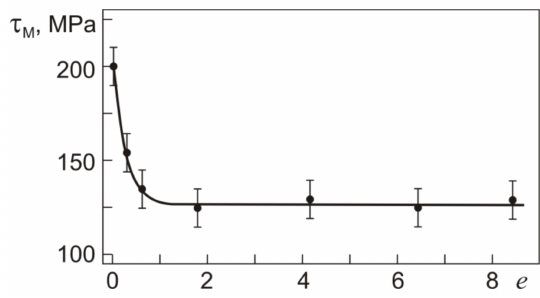
Figure 4. Martensite shear stress τ M vs. true strain e in T 49.8 Ni 50.2 in torsion at 295